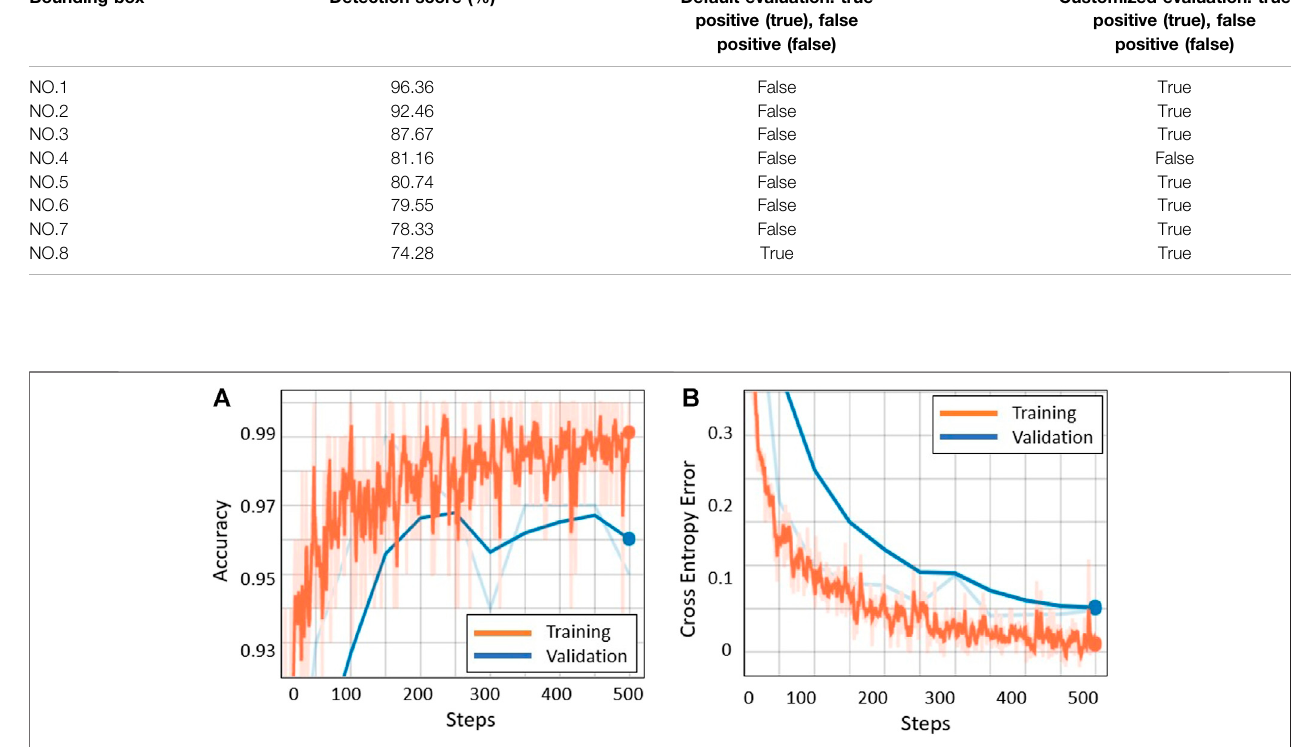
TABLE 1 | Results comparison for the detection output in Figure 5 between the default and the modi fi ed Faster R-CNN evaluation criteria. Bounding box